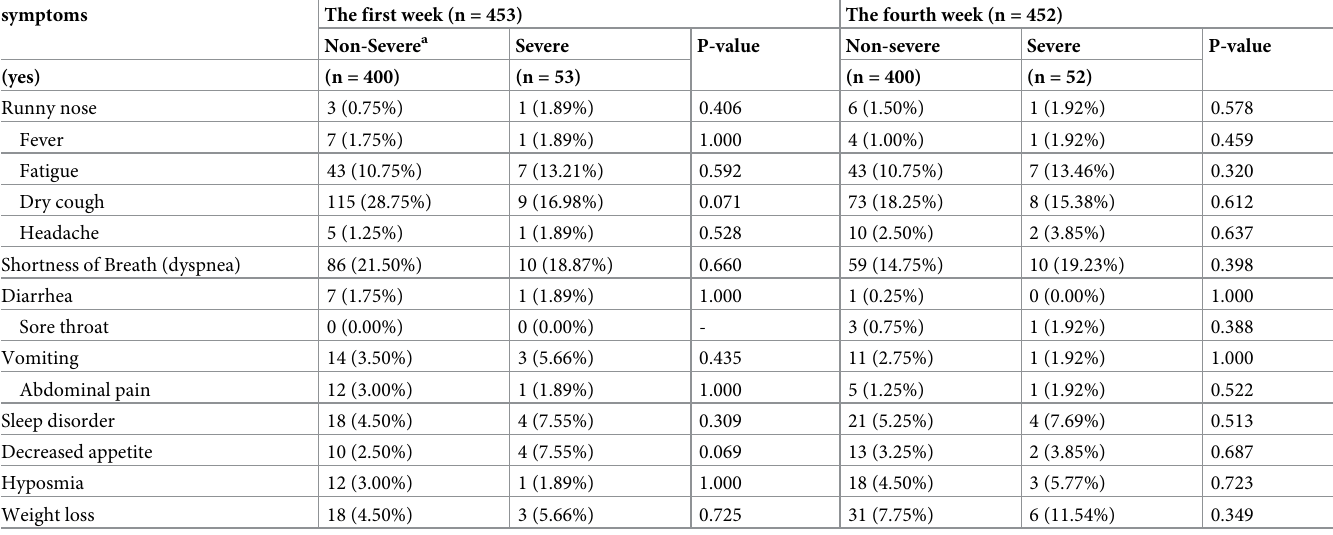
Table 3. The clinical symptoms of the COVID-19 patients during four weeks of follow- up.